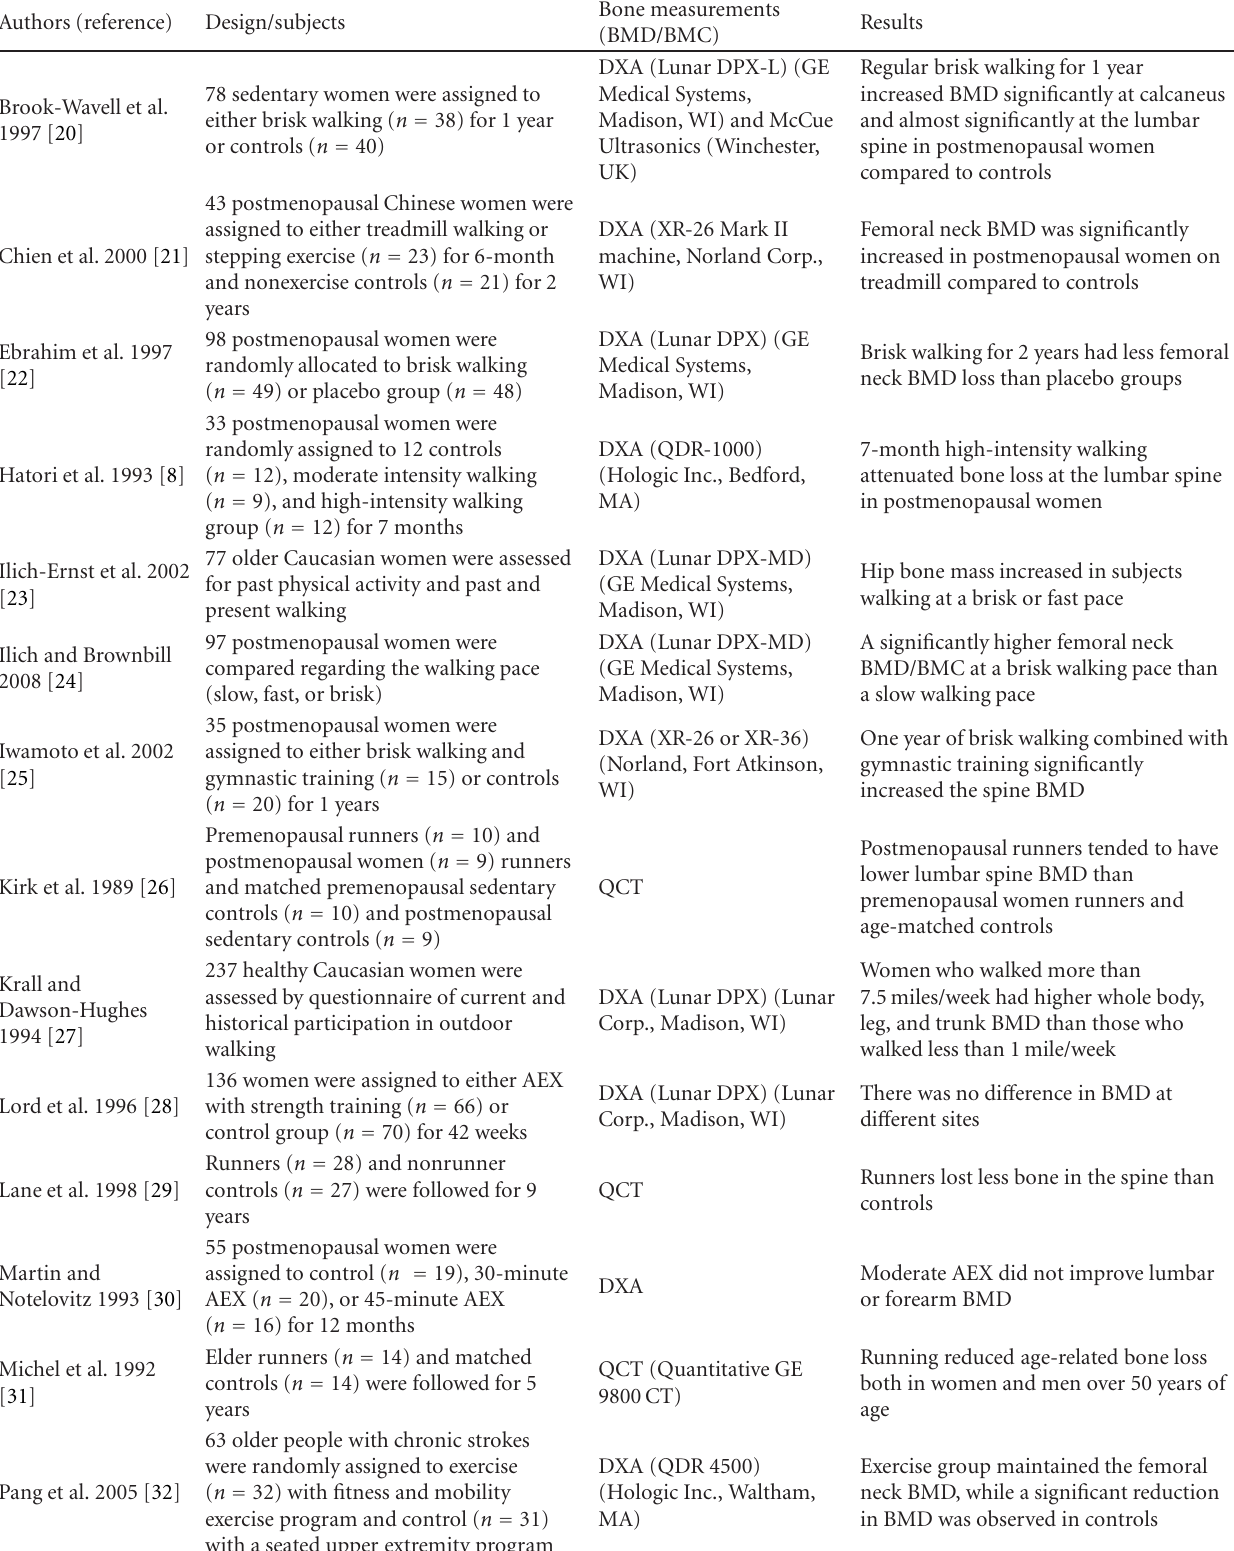
Table 1: Snap-shot of the relevant studies ∗ investigating the relationship of aerobic exercise and BMD of various skeletal sites. Authors